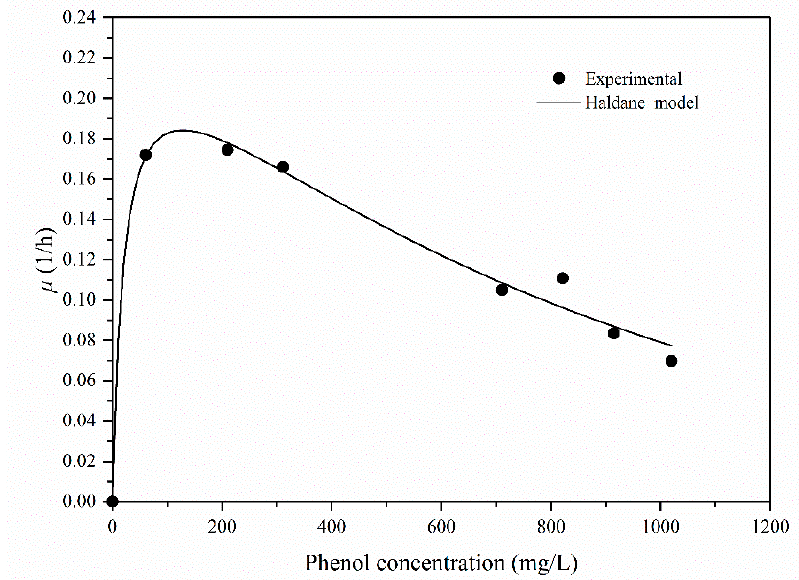
Figure 6. Phenol-specific growth rate profiles at the initial phenol concentration.